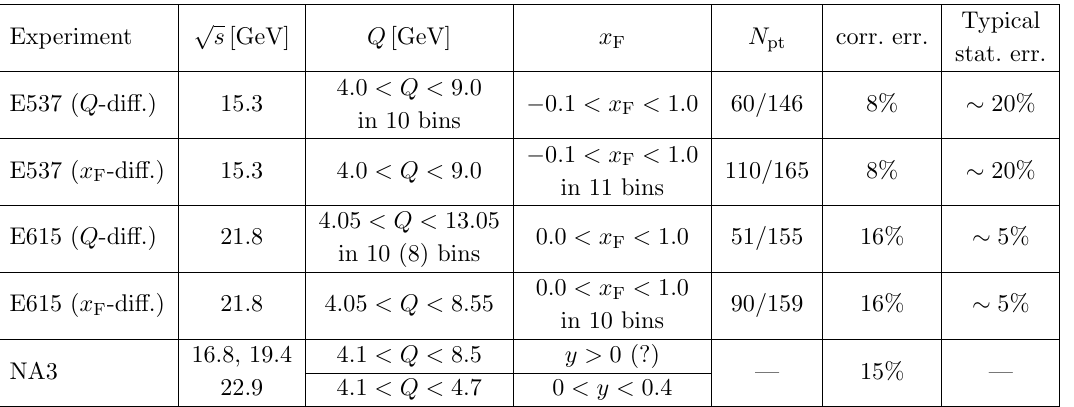
Table 1 . The synopsis on the data used in the work. N pt is the number of points in the data set after/before the application of TMD factorization cut. Typical statistical error is estimated from the (cid:12)rst 3 points for each ( Q; x F )-bin, and presented only for demonstration purposes. The data for NA3 is available only as a (cid:12)gure ((cid:12)gures 1 and 2 in ref.